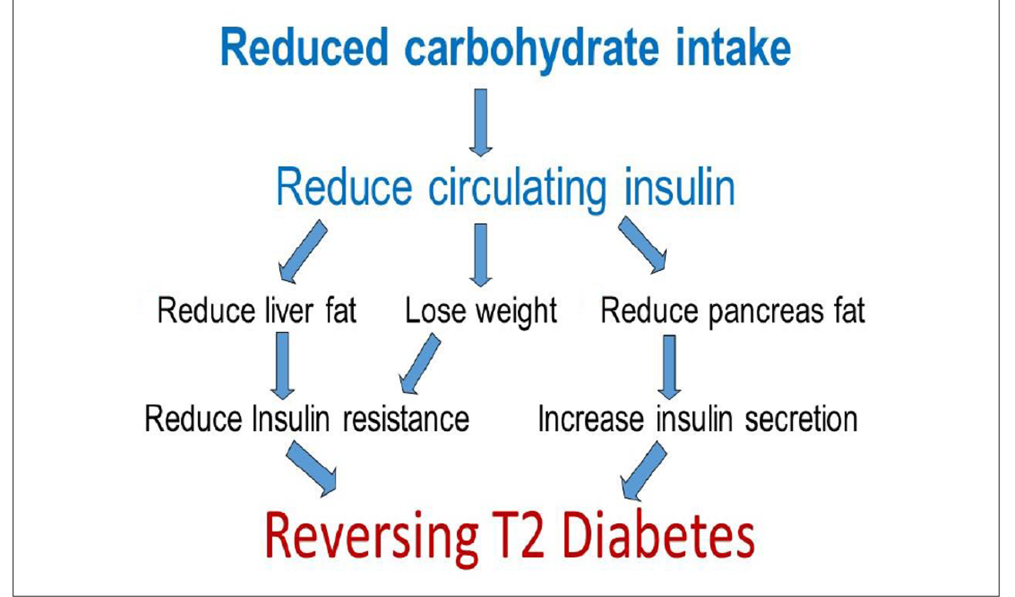
Figure 1. A simplistic model describing the mechanism by which reducing overall energy and